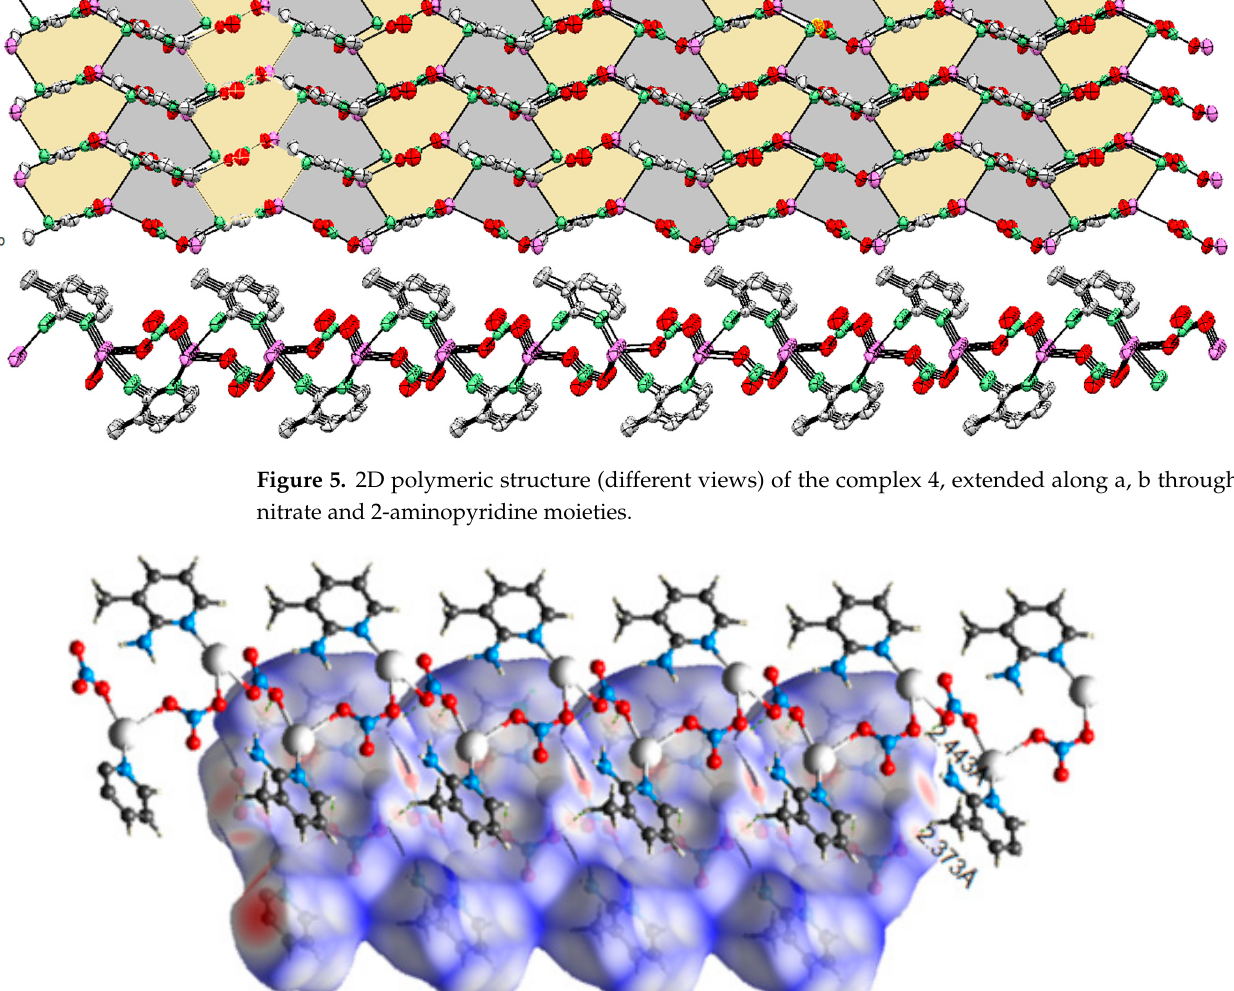
Figure 5. 2D polymeric structure (di ff erent views) of the complex 4, extended along a, b through nitrate and 2-aminopyridine moieties.